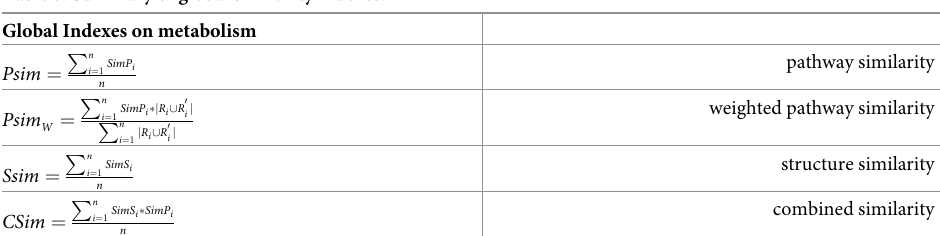
Table 3. Summary of global similarity